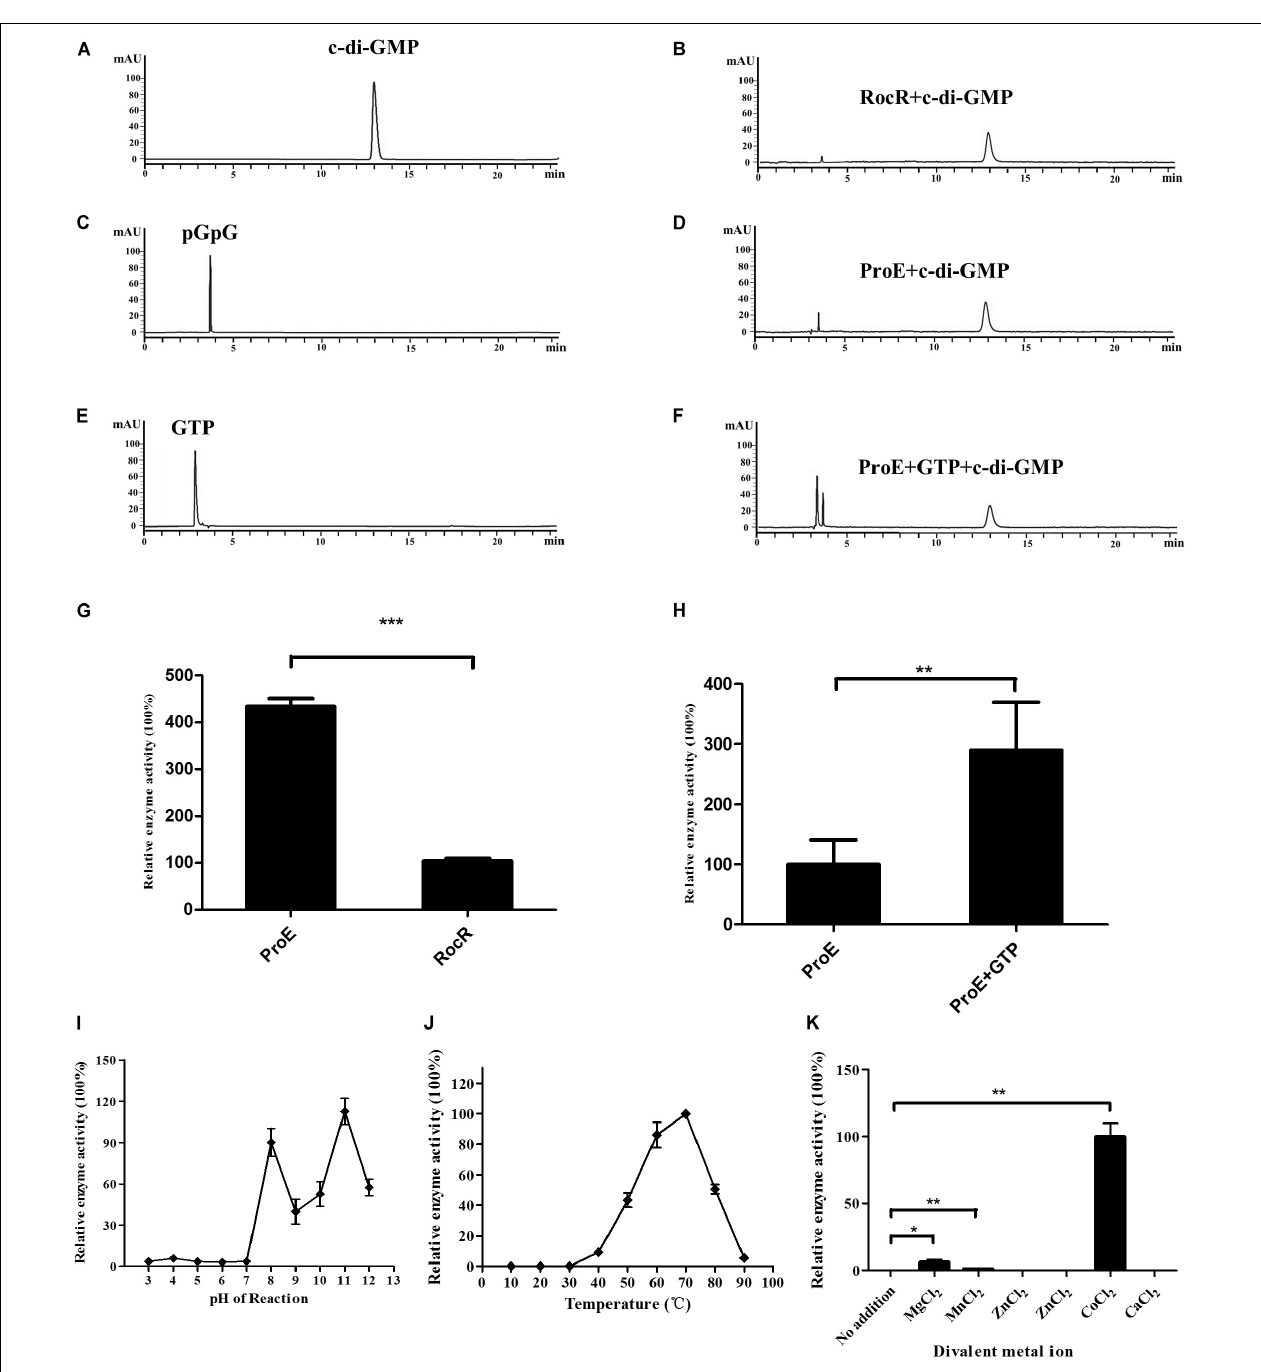
FIGURE 4 | Purified ProE is an active phosphodiesterase. (A,C,E) The standard of c-di-GMP (A) , pGpG (C) , GTP (E) in a final concentration of 100 µ M was prepared in the reaction buffer, and 10 µ l was injected for HPLC analysis. (B) RocR and (D) ProE after incubation with c-di-GMP at a final concentration of 50 µ M at 37 ◦ C for 20 min. (F) ProE incubated with 50 µ M GTP for 5 min at room temperature prior to addition of c-di-GMP, then the enzyme activity was analysis by HPLC. (G) Quantification of the enzyme activity of ProE and RocR. (H) Quantification of the enzyme activity of ProE and ProE with GTP prior to addition substrate. (I) The influence of pH on enzyme activity. The pH of the phosphodiesterase reaction was adjusted to 3–12 prior to the addition of enzyme and substrate (37 ◦ C, 5 mM MgCl 2 ). ProE activity was higher in alkaline condition. (J) The influence of temperature on enzyme activity. The ProE phosphodiesterase reaction was performed at a range of temperatures from 10 ◦ C to 90 ◦ C (pH 8.0, 5 mM MgCl 2 ). The highest rate of c-di-GMP hydrolysis was achieved at 60 ◦ C and 70 ◦ C. At temperatures lower than 30 ◦ C, no activity was detectable. (K) Dependence of the phosphodiesterase activity of ProE on divalent metal cations. Reaction buffer (37 ◦ C, pH 8.0) The data are means of three replicates and error bars indicate standard deviation. * P < 0.05; ** P < 0.01, *** P < 0.0001.